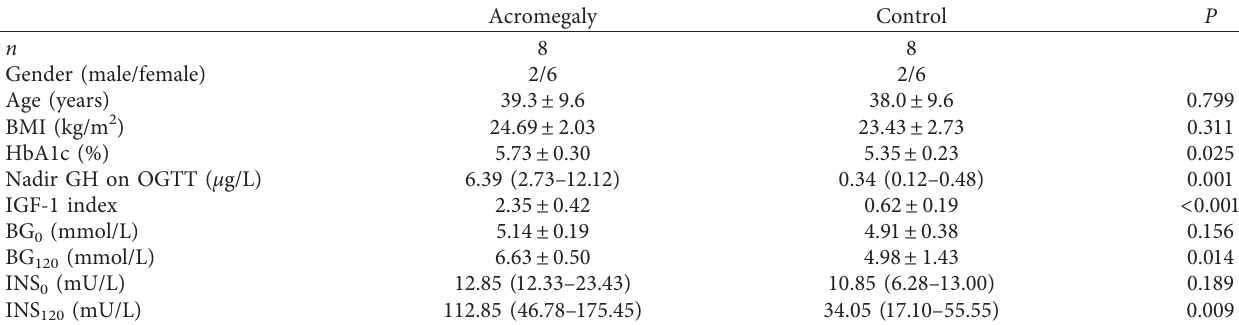
Table 1: General characteristics of the study participants.